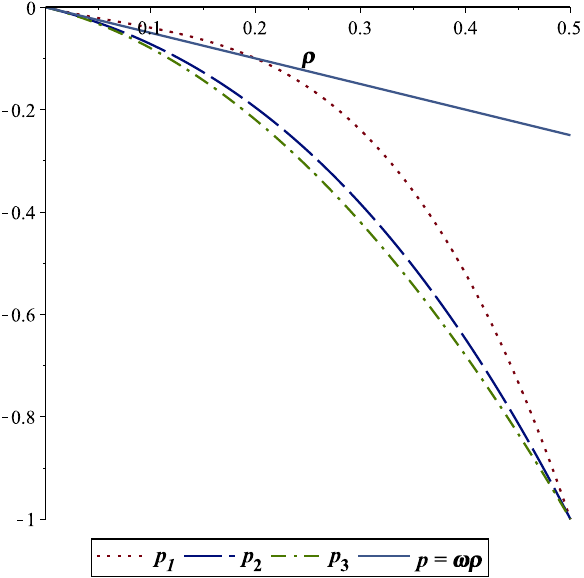
Fig. 13 The plot depicts the three special EoS p 1 (dotted line), p 2 (dashed line), p 3 (dotted-dashed line) and p = ωρ (solid line) as a functionof ρ .Itisevidentthat p 1 hasthemostconsistencywith p = ωρ . So the EoS with extra terms can increase the opportunity of consistency with linear EoS. See the tex for details is satisfied. Note that we have considered 8 π G = C = 1.